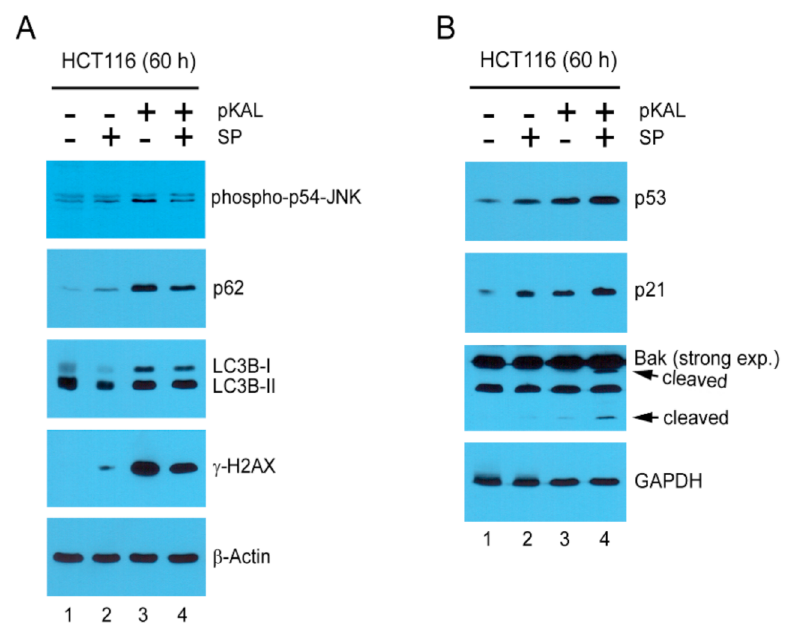
Figure 8. Mechanisms related to the enhancement of pKAL-induced cell death by SP600125: HCT116 cells were grown with 50 µ g/mL pKAL for 12 h, then treated with 2 µ g/mL SP600125, and cultured for an additional 48 h. Cells were analyzed by Western blot using the indicated anti- bodies; the arrows represent the low-molecular-weight cleaved forms of Bak: ( A ) downregulated pKAL-dependent targets by the co-treatment of SP600125; ( B ) up regulated pKAL-dependent targets by the co-treatment of